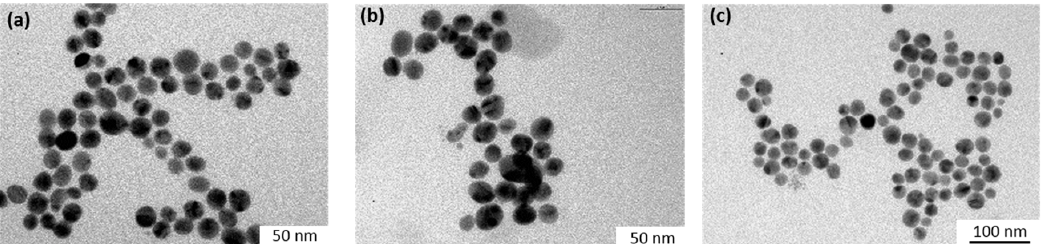
Figure 11. TEM images of the initial 15 nm Au-NPs@pNTP taken at different times during the reduction reaction of hexacyanoferrate (III) under LED irradiation at 520 nm: ( a ) 10 minutes; ( b ) 30 minutes; and ( c ) 60 minutes of irradiation.